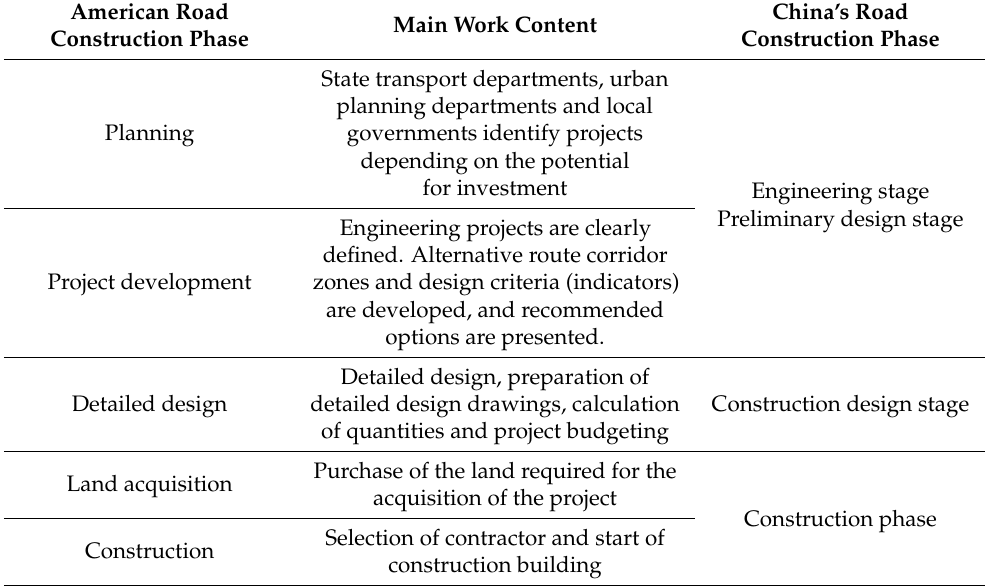
Table 2. Comparison table of highway construction stages in China and the United States. American